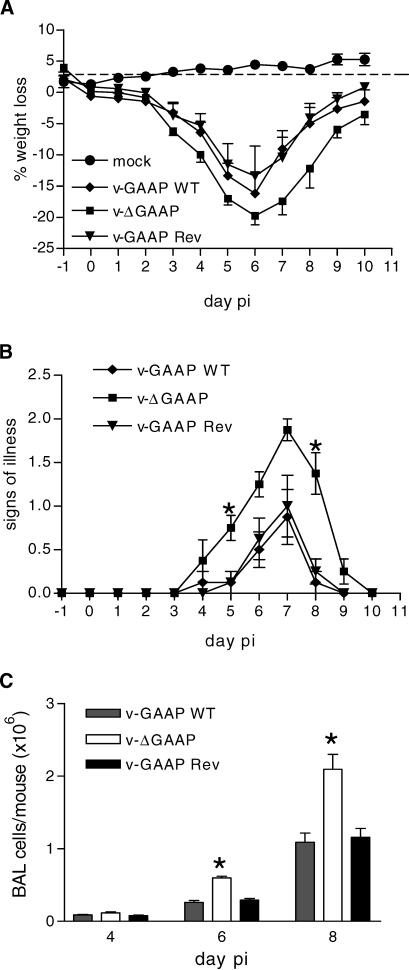
v-GAAP Is an ImmunomodulatorGroups of four BALB/c mice aged between 6 and 8 wk were mock-infected with PBS (•) or infected with 107 pfu of v-GAAP WT (♦), v-ΔGAAP (), or v-GAAP Rev (▴).(A) Mice were weighed daily, and results are the mean percentage weight change of each group ± standard error of the mean (SEM) compared with the weight on the day of infection.(B) Animals from (A) were monitored daily for signs of illness, which was scored as described [27]. Data are expressed as the mean ± SEM. p-Values were determined by using Student's t-test and indicate mean weight loss (A) or mean signs of illness. *, p-values of mice infected with v-ΔGAAP that were significantly different from those of mice infected with v-GAAP WT and v-GAAP Rev (B).(C) Mice infected intranasally with 107 pfu of v-GAAP WT, v-ΔGAAP, or v-GAAP Rev were sacrificed at various days p.i. as indicated. BAL cells were recovered and counted. Columns represent the mean cell yield per mouse ± SEM. Those marked with an asterisk indicate mean cell numbers recovered with v-ΔGAAP that were significantly different (p < 0.05) from those recovered from v-GAAP WT and v-GAAP Rev (three independent experiments with groups of four to five mice).